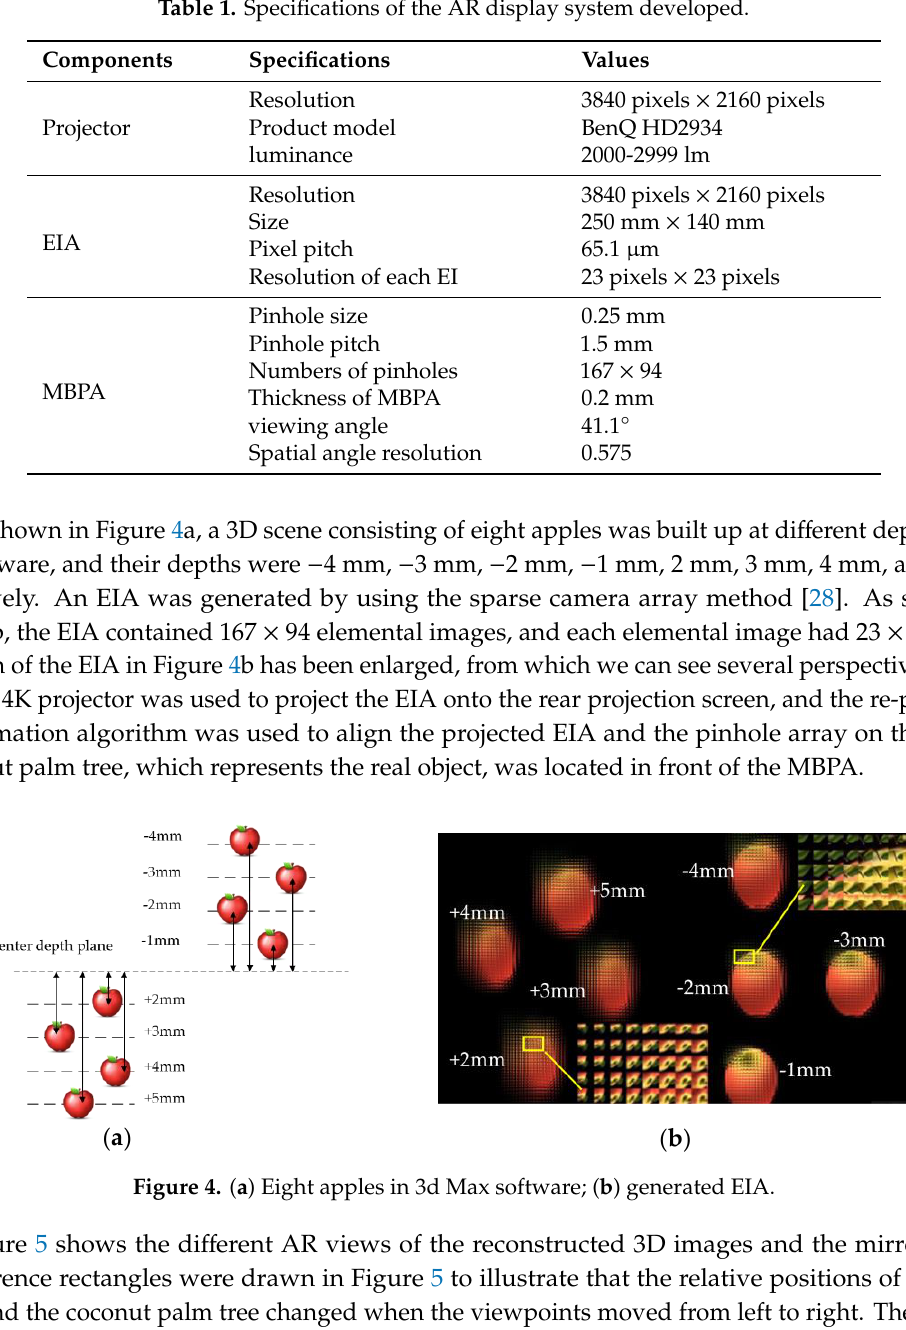
Figure 6. AR fitting application by using the proposed prototype. ( a ) Right view ; ( b ) left view; ( c ) right view , and ( d ) left view. 4. Discussions The resolution of the system is determined by the number of pinholes, because the viewer sees one pixel from each EI, and the brightness of the system is directly affected by the pinhole